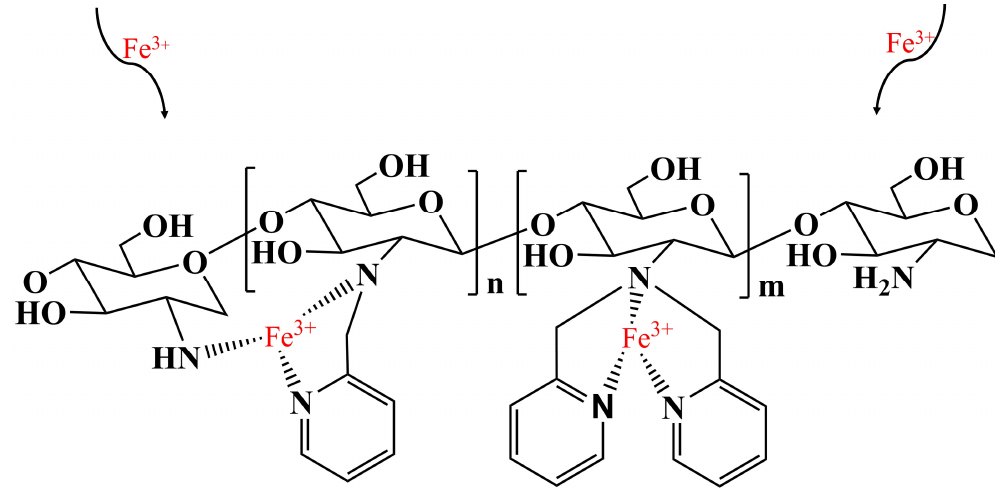
Figure 10. Possible mechanism of the adsorption process.